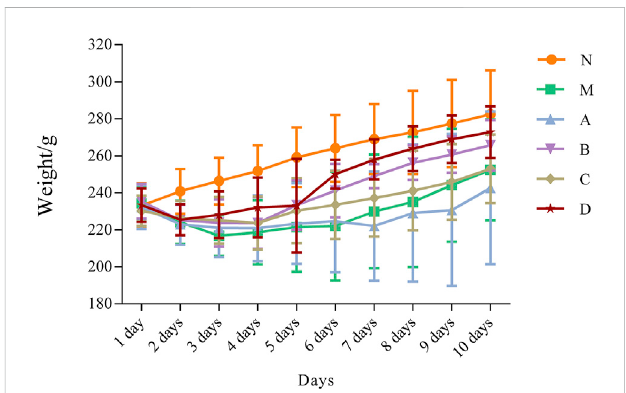
FIGURE 1 Line chart of changes in body weight of rats during the experiment N, normal group; M, model group; A, suet oil group; B, Epimedium raw product group; C, Epimedium heating product group; D, Epimedium fried with suet oil